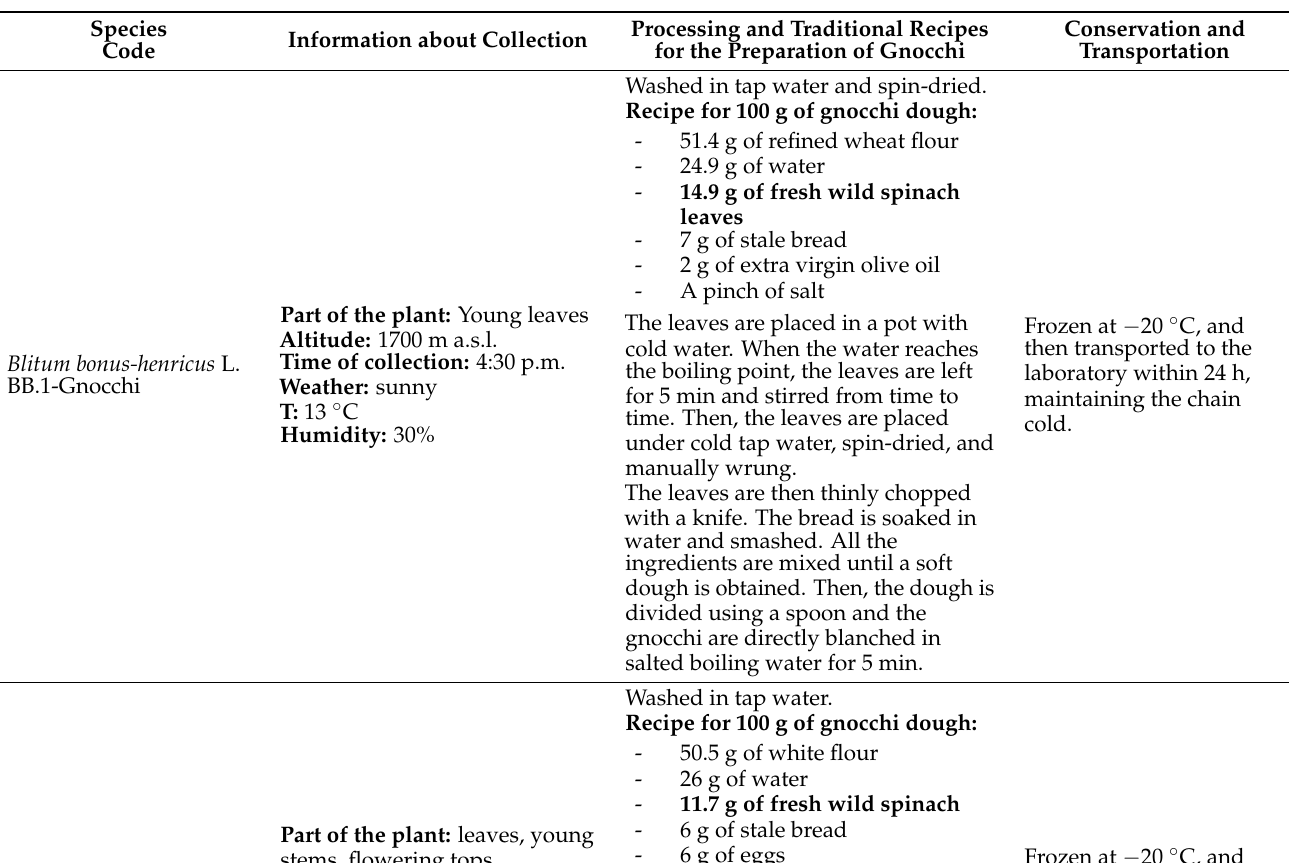
Table 2. Traditional green gnocchi recipes followed during the